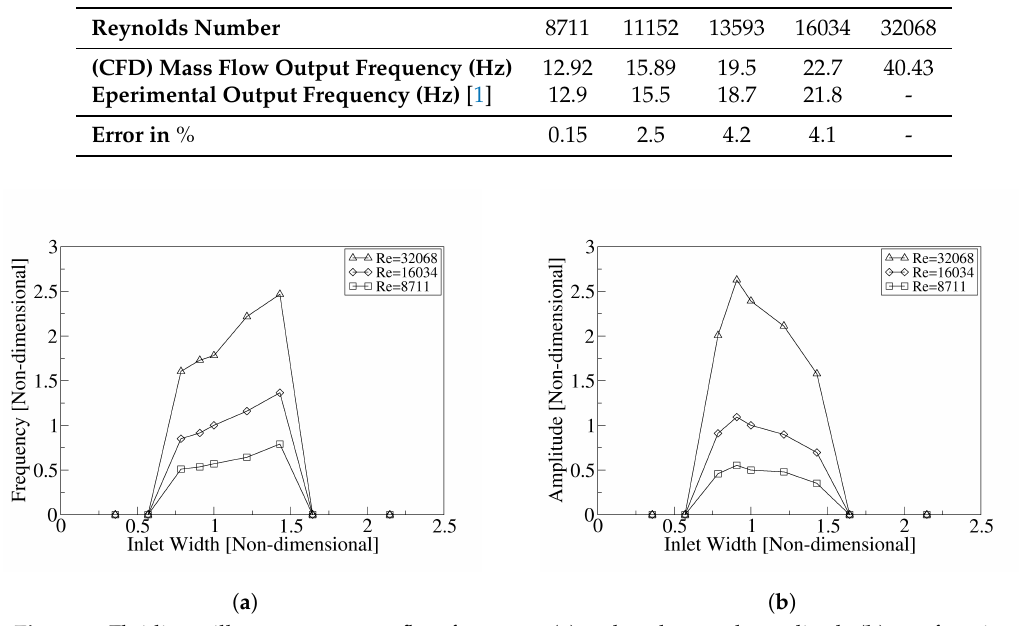
Figure 3. Fluidic oscillator output mass flow frequency ( a ) and peak to peak amplitude ( b ) as a function of the mixing chamber inlet width and for three different Reynolds numbers, 8711, 16034 and